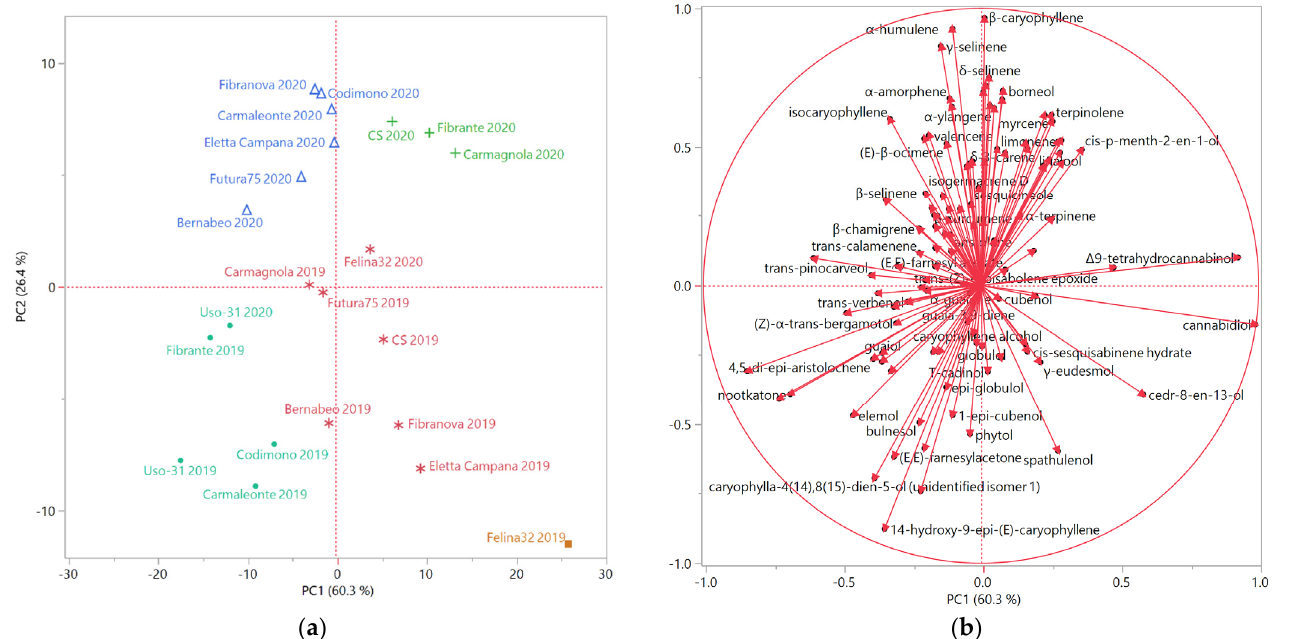
Figure 2. ( a ) Score plot of the principal component analysis (PCA) performed on the complete composition of the essential oils extracted from all the hemp samples; ( b ) Loading plot of the principal component analysis (PCA) performed on the complete composition of the essential oils extracted from all the hemp samples.